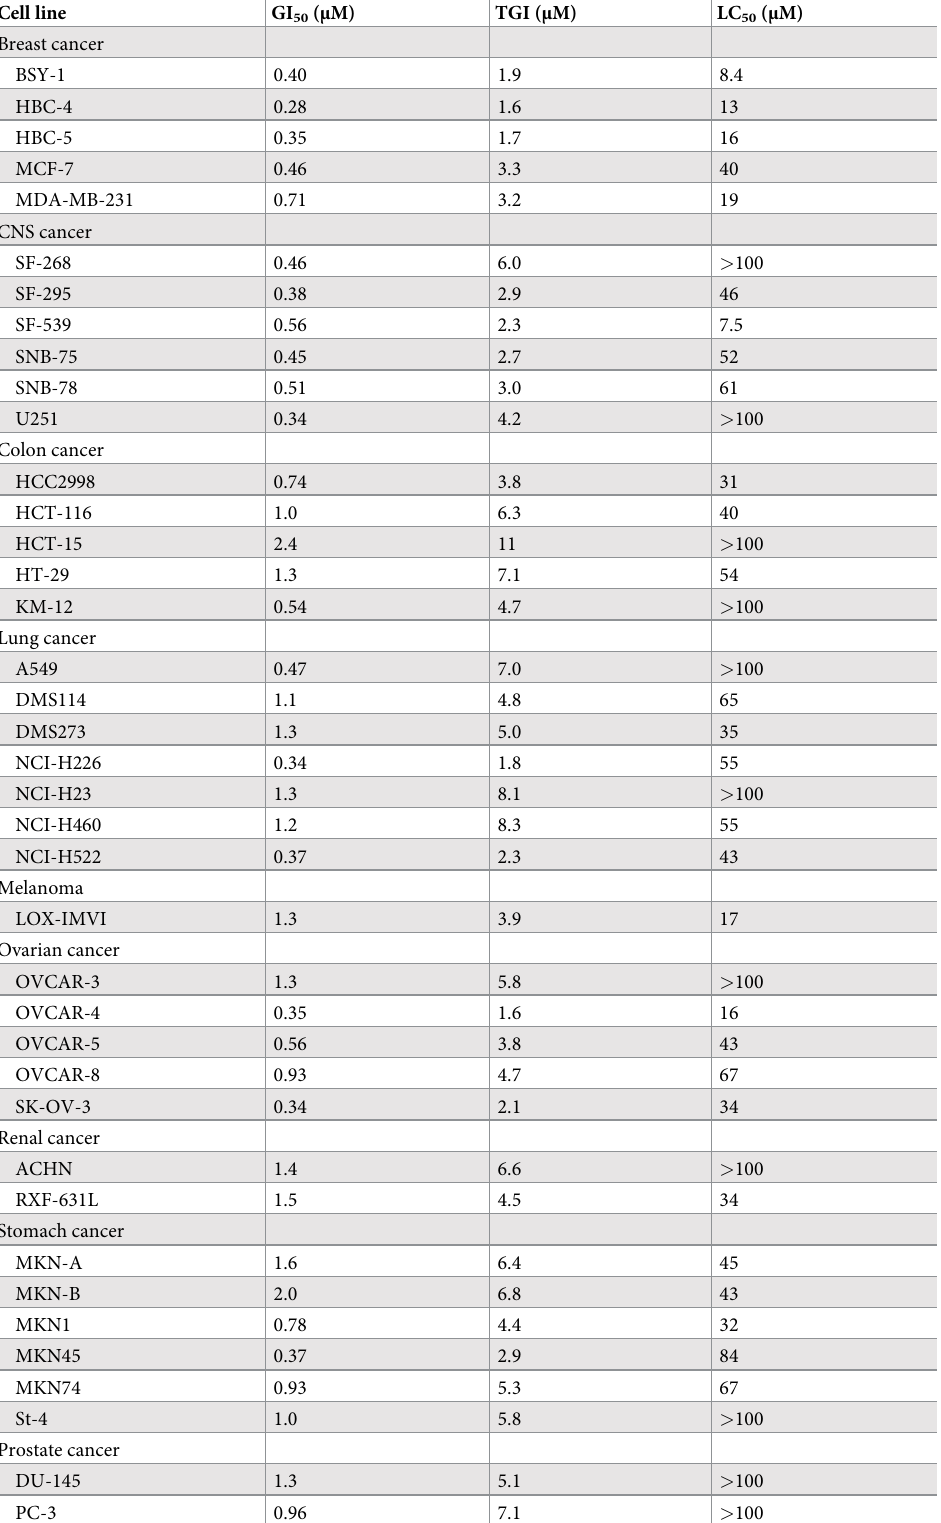
Table 1. Indices showing the inhibitory activity of diaphorin against the 39 human cancer cell